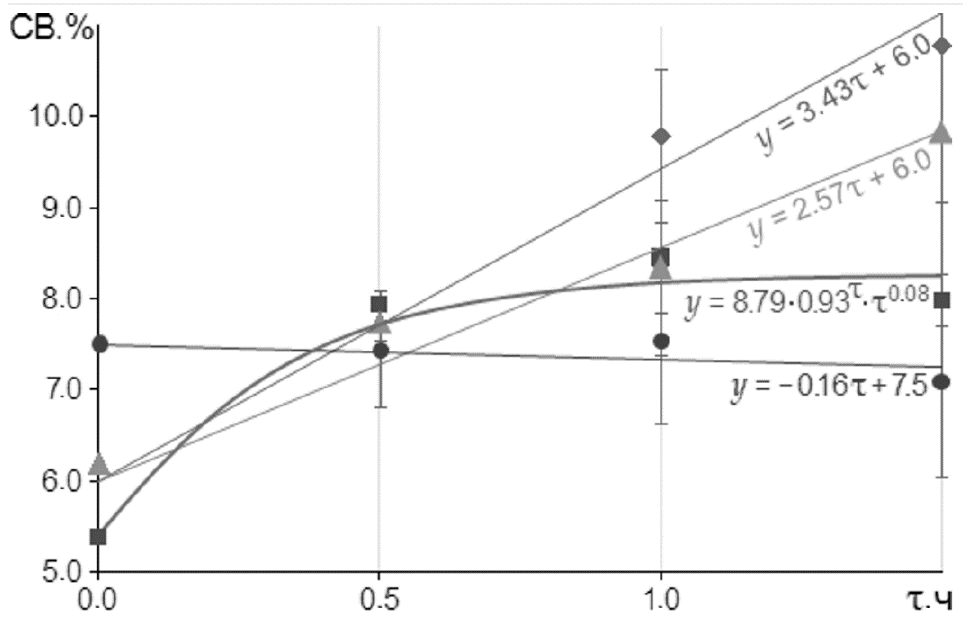
Figure 2. Dynamics of accumulation of dissolved solids in juice, ▲ Fructozym UF, ⬥ Fructozym P6-L, ■ Fructozym FLUX, ● Without enzyme preparate.